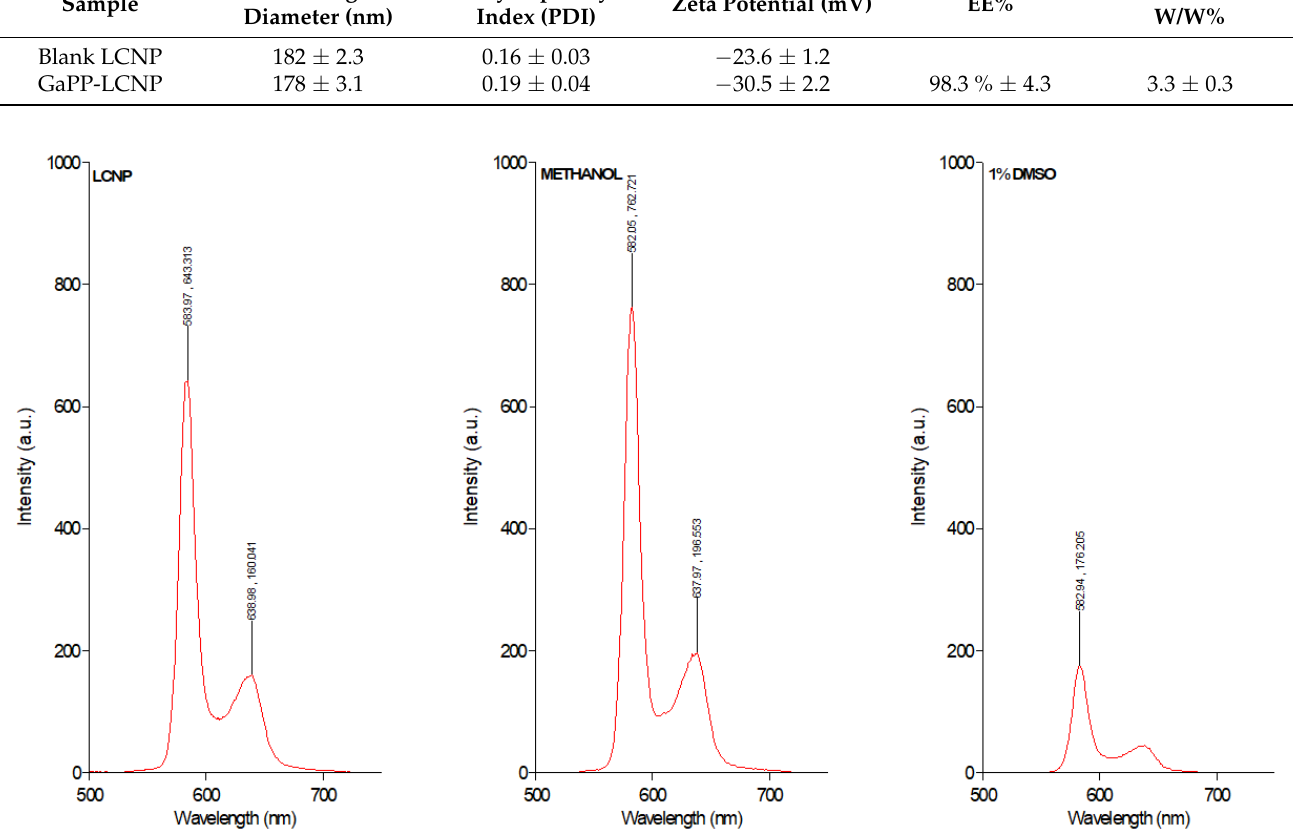
Figure 1. Fluorescence intensity of GaPP 0.3 µM dissolved in LCNP, methanol and aqueous solution containing 1% DMSO.